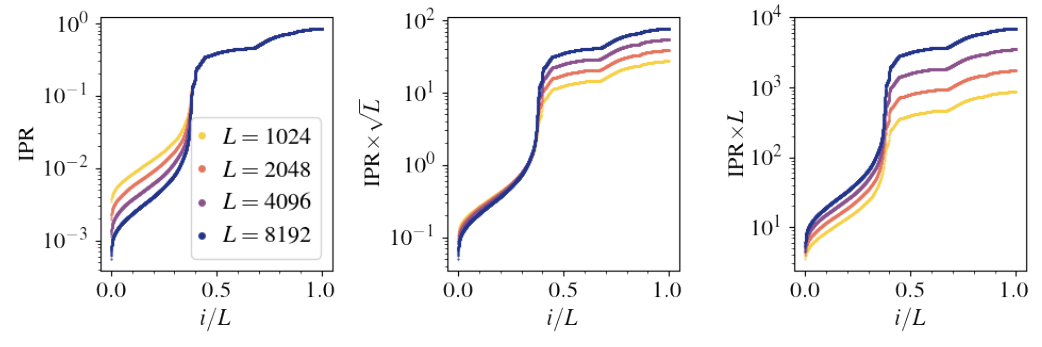
Figure 13: IPRs at lower driving frequency. The (scaled) IPRs similar to Fig. 2 for a much lower value of driving frequency Ω = 2.5 π J . The persistence of the multifractal states shows that no fine-tuning is needed in the driving